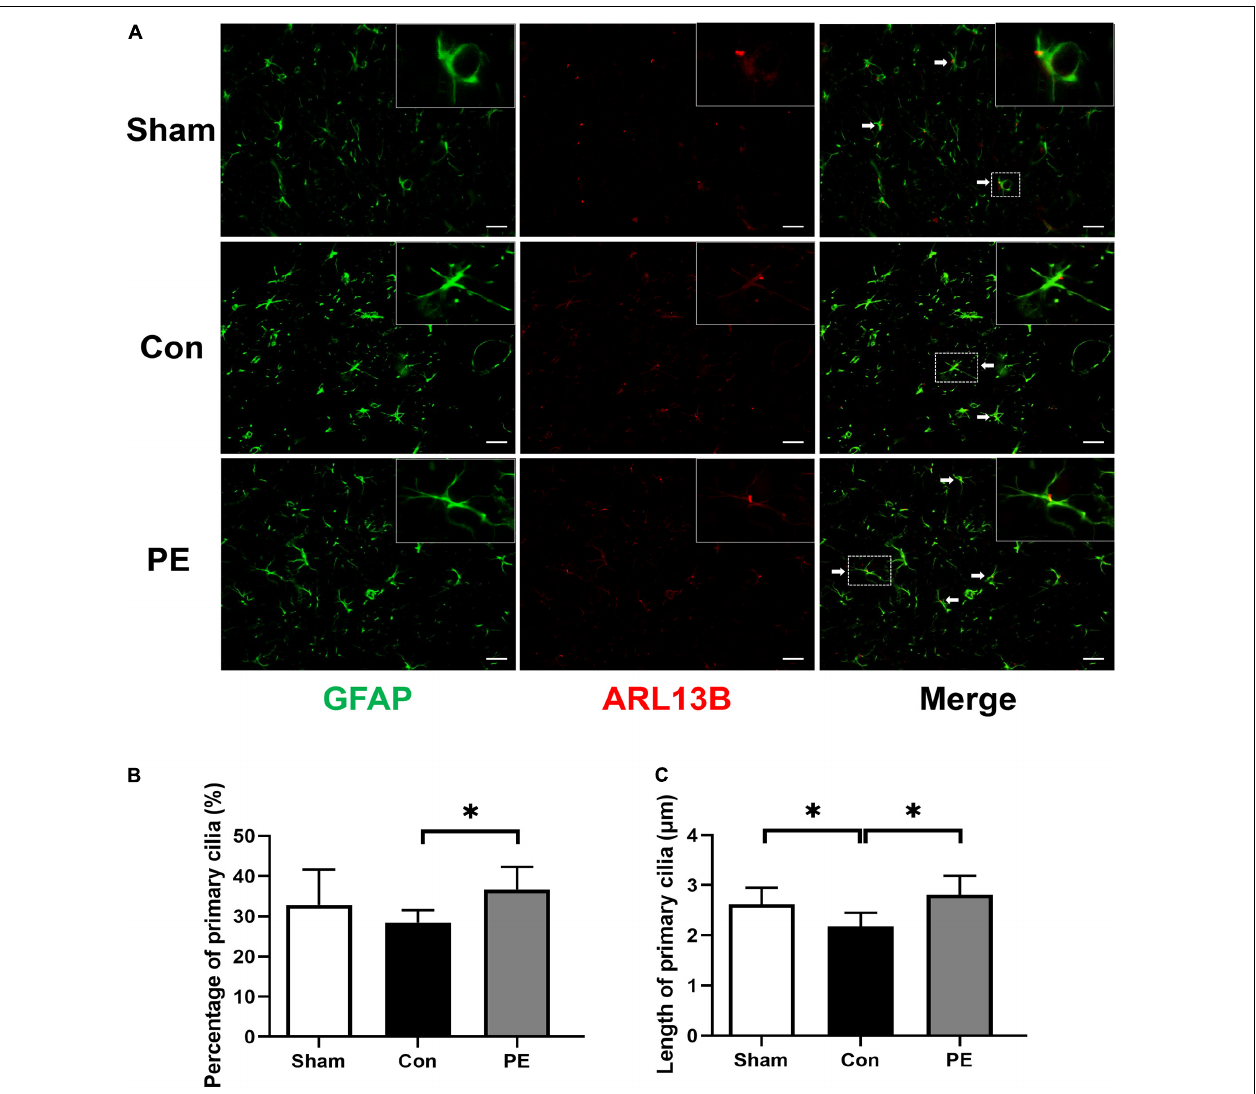
FIGURE 5 | Physical exercise augmented the expression and length of primary cilia in astrocytes. (A) Representative immunofluorescence images for GFAP (green) and ARL13B (red) double staining of rats in each group in the corpus callosum. Scale bar = 50 µ m. (B) Quantification of the percentage of astrocytes containing primary cilia. (C) Quantification of length of astrocytic primary cilia. n = 6. Experimental data are expressed as the means ± SD. ∗ P < 0.05. ARL13B, ADP-ribosylation factor-like